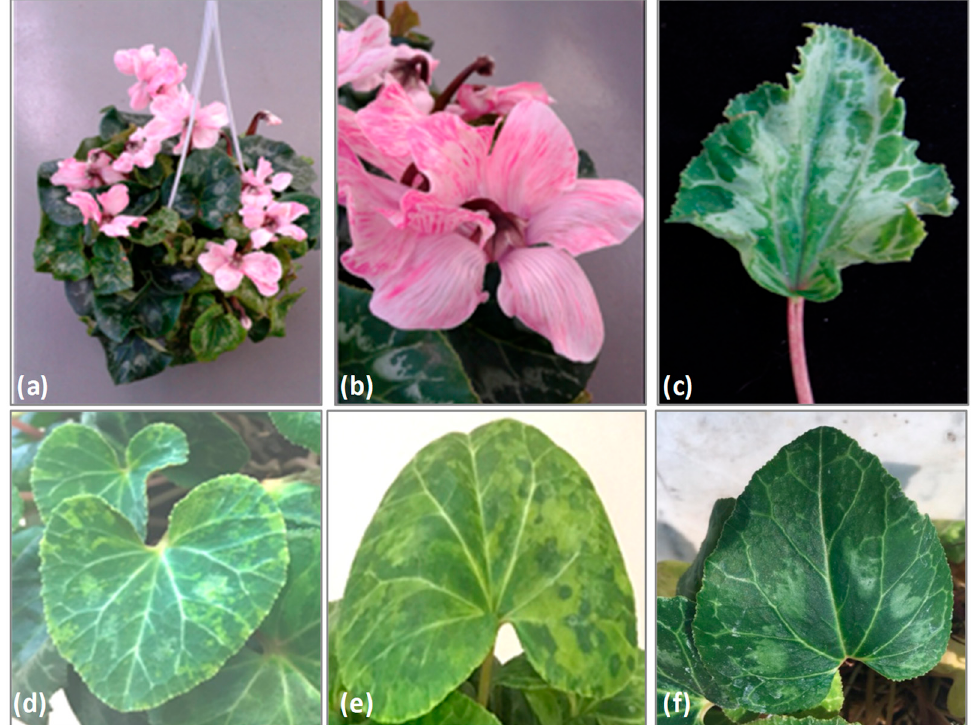
Figure 1. Symptoms observed on Cyclamen persicum (accession Cic) found infected with Fig mosaic emaravirus (FMV). ( a ) Cic-potted plant; ( b ) flowers showing color breaking and stripes; ( c ) Leaf with mottling, light yellowing and deformation; ( d , e ) leaves grafted onto Cic- and G-potted accessions showing mottling and light yellowing symptoms; ( f ) healthy leaf of cyclamen.